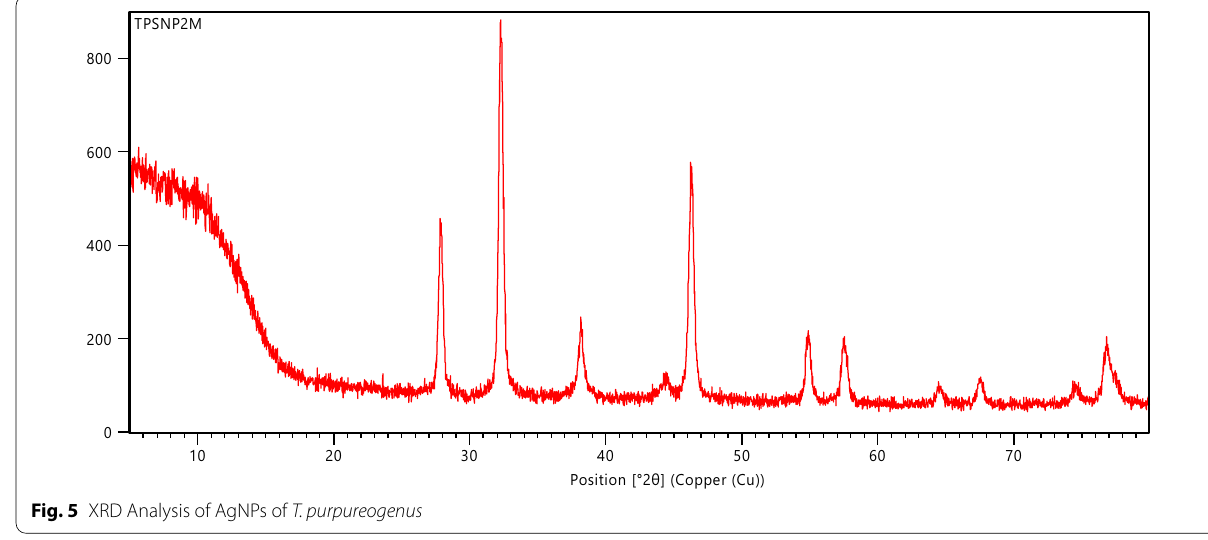
Fig. 5 XRD Analysis of AgNPs of T.